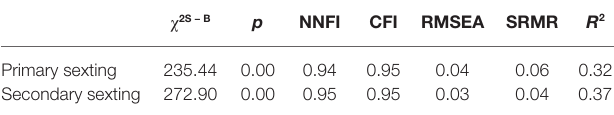
TABLE 7 | Fit indexes of the models’ active impact and sexting, incorporating the Need for Popularity.